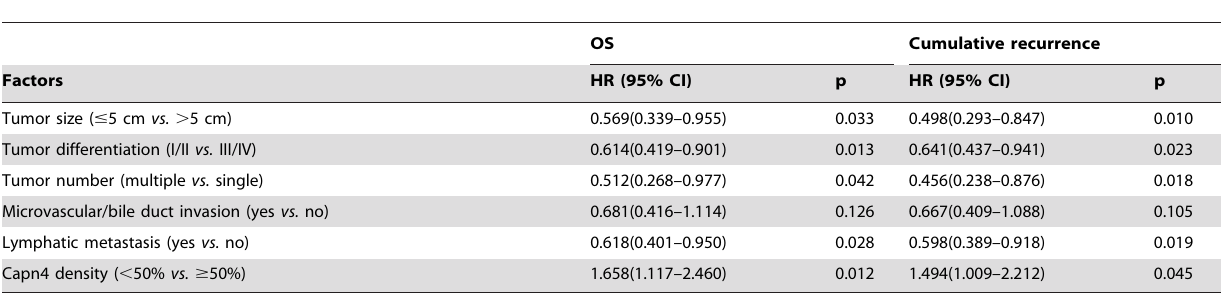
Table 3. Multivariate analysis of factors associated with survival and recurrence.